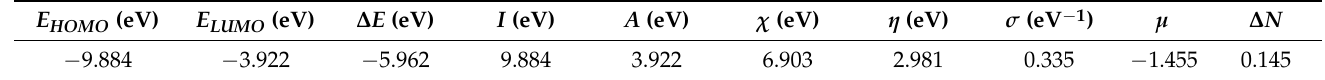
Table 3. Quantum chemical parameters for inhibitors at B3LYP/6-311G (d, p